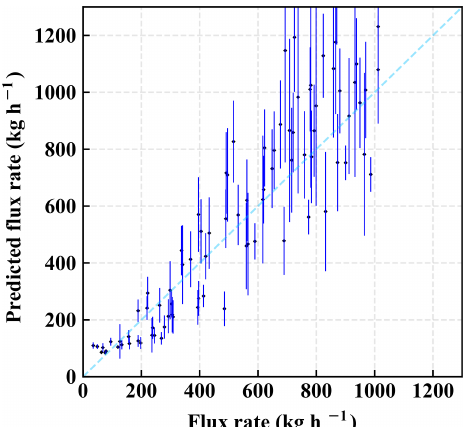
Figure 12. Comparison between the prescribed flux rate in the model run and the predicted flux rate based on our method of us- ing the IME and the angular width of plume in a given scene. The error bar represents uncertainties associated with the prediction of an individual point